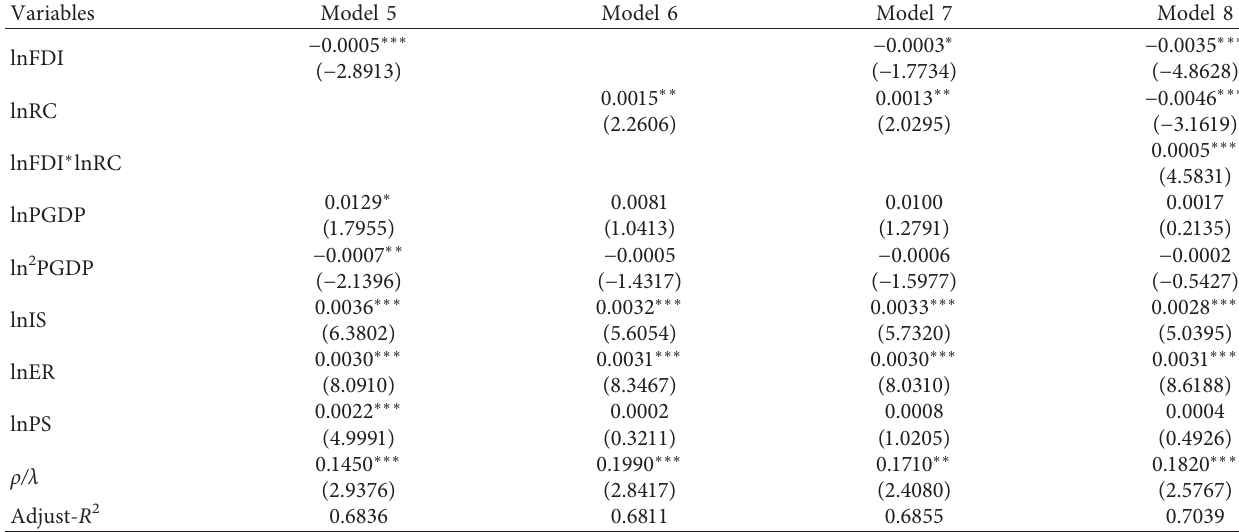
Table 5: Spatial panel model estimation results of FDI, regional corruption, and environmental